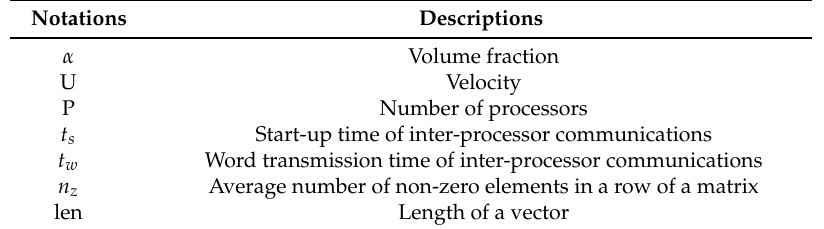
Table 2. Some descriptions of